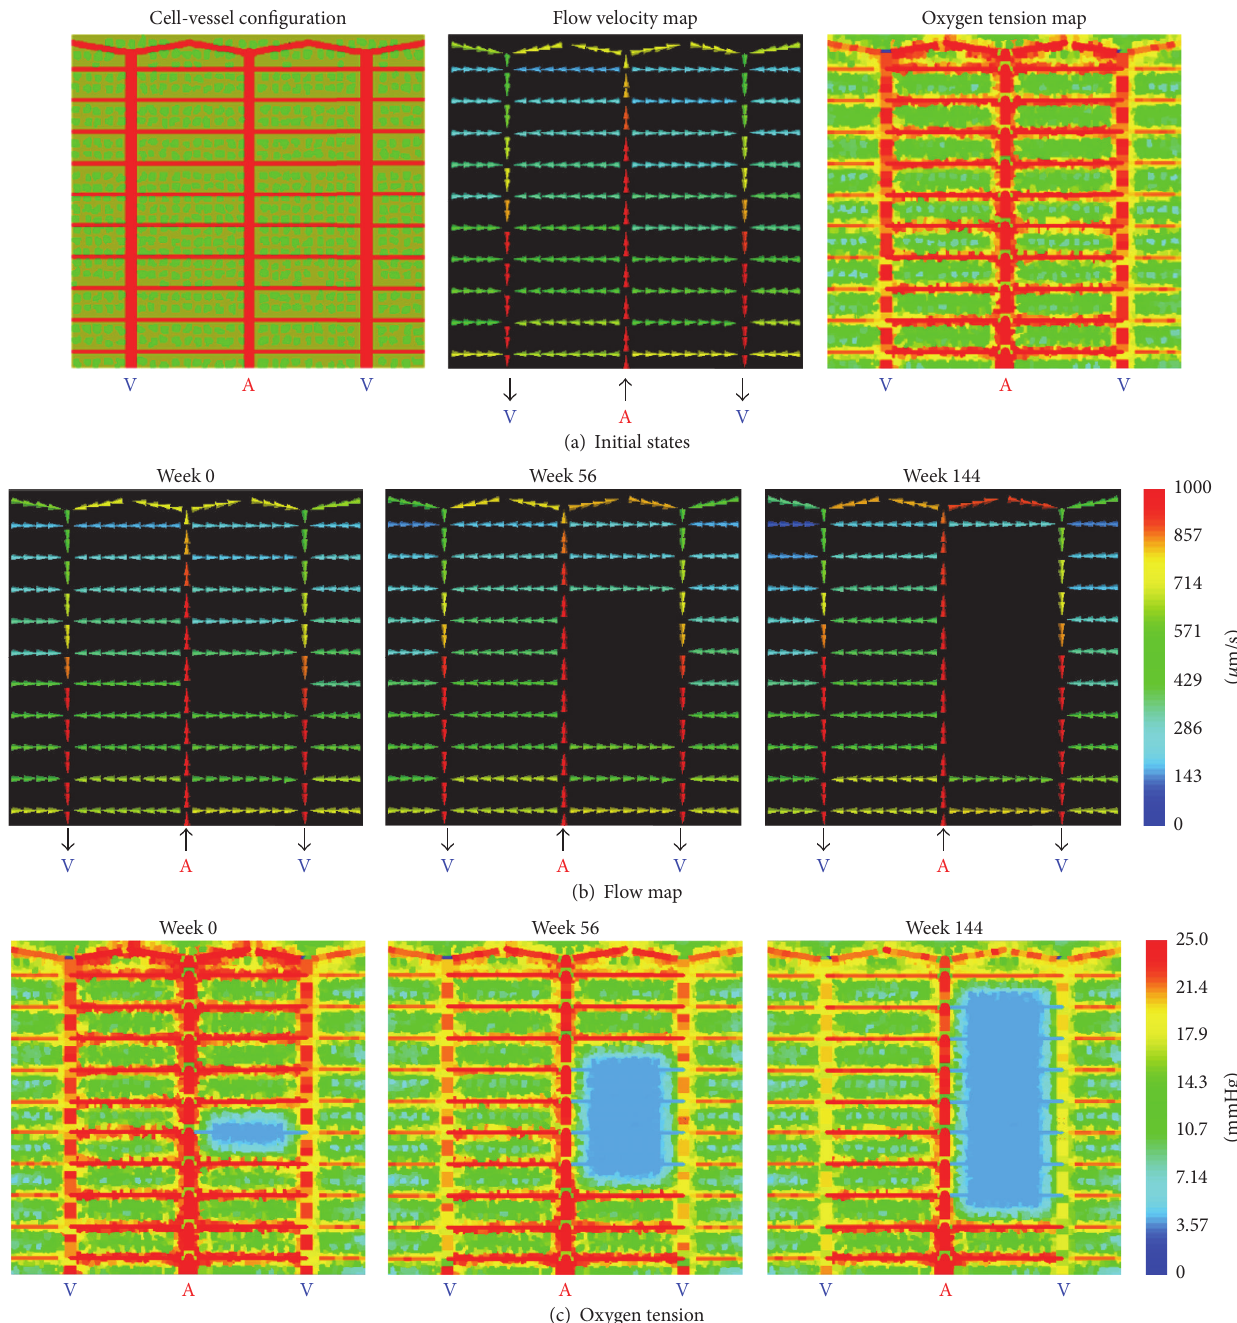
Figure 1: Pattern of capillary loss without burns. Normal condition of peripheral retina without photocoagulation. (a) (left) A 2D view of the configuration of the retinal capillary network, Mueller cells and other retinal cells in the in silico peripheral retina. Size of a Mueller cell (green) is 24 𝜇 m [39]. Size of other retinal cells (olive) is 21 𝜇 m. Diameter of arteriole (red) is 20 𝜇 m. Diameter of venules (red) is 25 𝜇 m. Diameter of shunting vessels at the top of the model area (red) is 18 𝜇 m. Capillary (red) diameter is 10 𝜇 m. Vessel pattern and diameters are from [25]. (Middle) flow velocity map of the vascular network. Capillaries carry blood flow with smaller velocities than arterioles, venules, and shunting vessels. (Right) oxygen tension map of the modelled section. Cells in the proximity of vessels have relatively higher oxygenation and redder colors than those located at a greater distance but no area is ischemic in the normal condition. (b) Evolution of the flow velocity map following initial capillary occlusion without photocoagulation. (Left) flow map shows closure of a capillary in AV sector. (Middle and right) a cascade of capillary occlusion instances propagates anteriorly and posteriorly within the same sector, and therefore the flow map shows a progressively larger gap. Color bar has units 𝜇 m/s. Warmer color represents greater flow velocity. (c) Evolution of the oxygen tension map following initial capillary occlusion without photocoagulation. (Left) oxygen tension map shows a group of poorly oxygenated cells near occluded vessel. (Middle and right) area of the ischemic region expands in response to the increasing number of derived capillary occlusion instances. Also oxygen tension in the venules drops with time. Color bar has unit mmHg. Warmer color represents higher oxygen